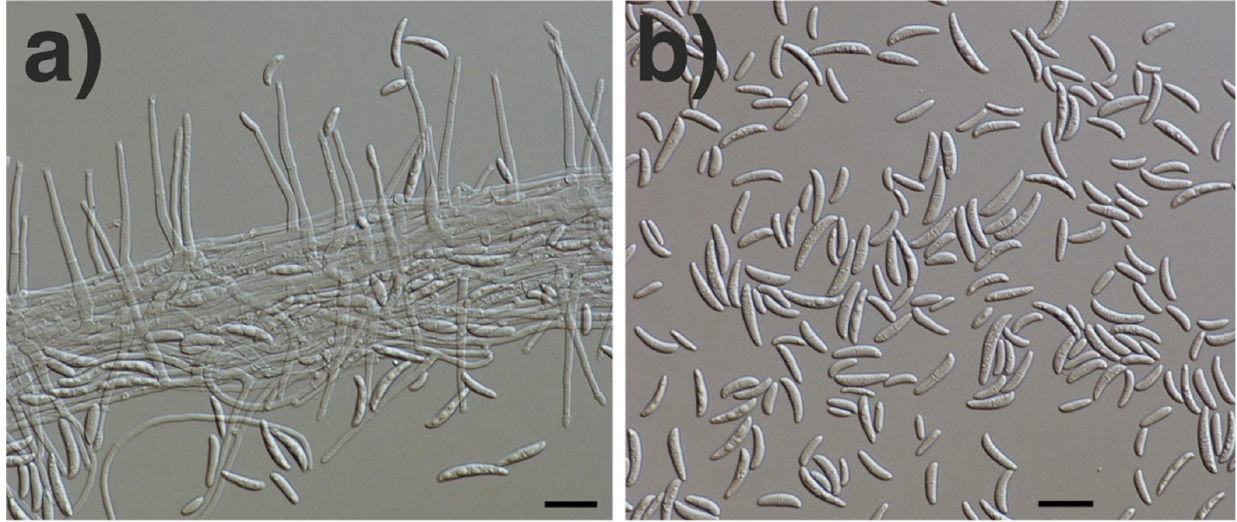
Figure 9. Colony morphology of isolated Fusarium sp. after 10 days on Sabouraud agar at 26 °C. ( a ) Front side: Fluffy colony ( b ) Reverse side: ochre-coloured pigment.